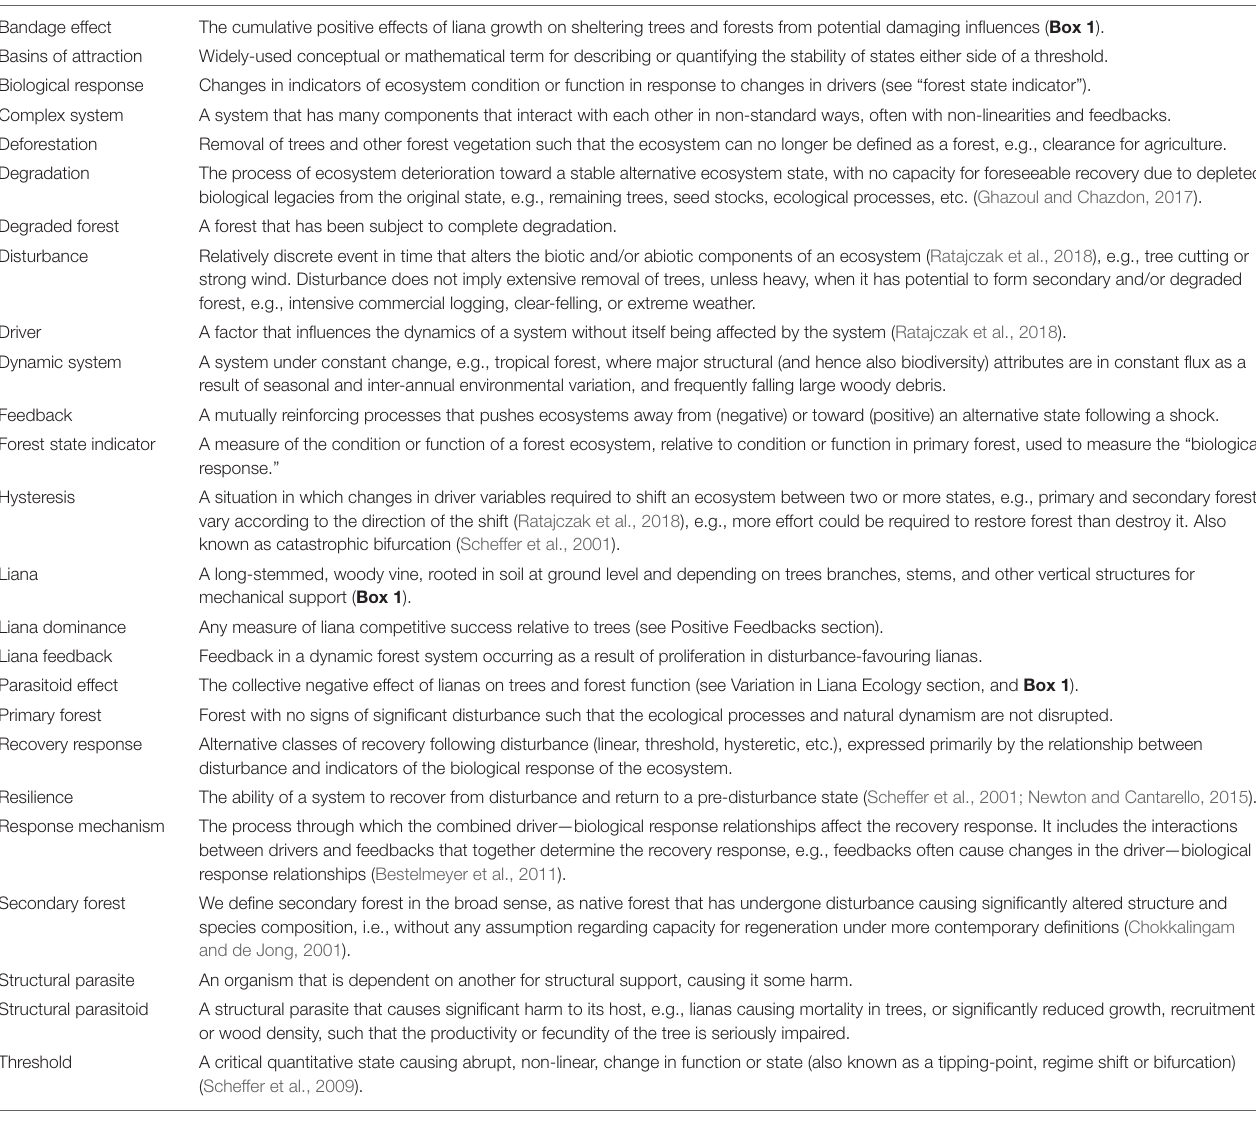
TABLE 1 | Glossary of key terms used in this article, beyond those described in the main text. Bandage